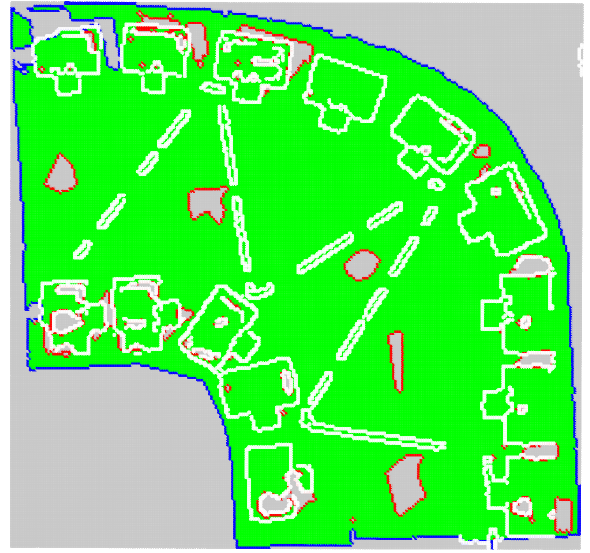
Figure 4. Classification of the grid cells. The exterior boundary of the surface (blue points), the boundaries of the horizontal holes (red points) and the vertical holes (white points) Detection of height jumps and vertical holes During the creation of the height map, the jumps in the height and the potential vertical holes are detected. Large height differences in the surface may lead to occlusions causing holes in the point cloud. Therefore, we need the detected height jumps for deciding whether it is reasonable to return to the hole trying to close it. It might be possible to clear up some occluded area from the UAS, but that depends on knowledge about the occluded area or making assumptions on the nature of the surface in the area. The first step is to detect height jumps. As the height map contains the minimum and maximum z-coordinates from the points in each cell, height jumps can be detected by comparing the difference of these against a given threshold height